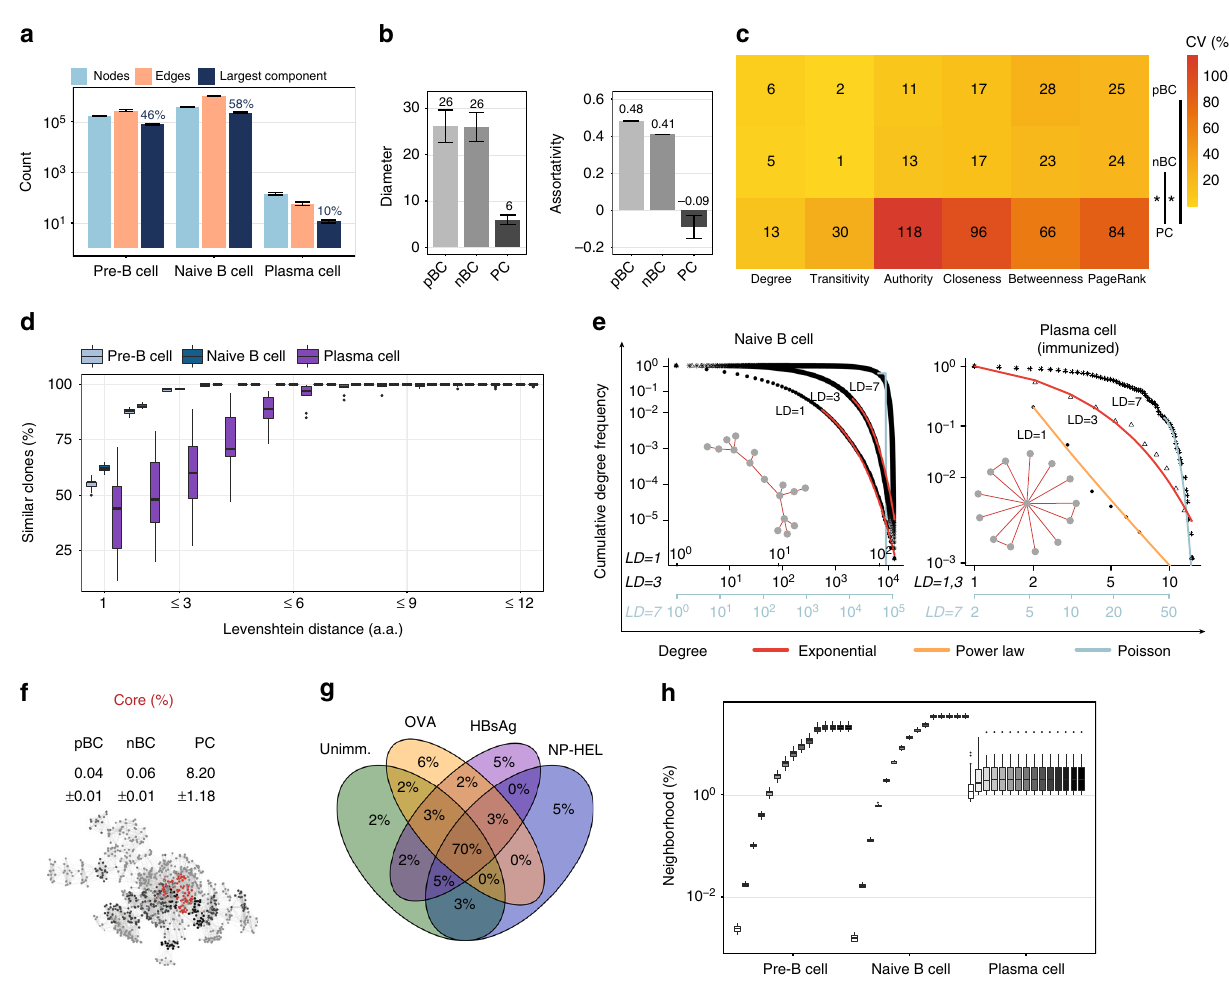
Fig. 2 Global and clonal properties of antibody repertoire networks are reproducible. a Network size of antibody repertoires. The y -axis indicates the absolute number count of CDR3 nodes, CDR3 edges (similarities) and CDR3 clones in the largest component. The mean percentage of the CDR3s belonging to the largest component by B-cell development stage is shown on top of the dark blue bar. b Global properties, diameter and assortativity coef fi cient are shown for pre-B cells (pBC), naïve B cells (nBC) and plasma cells (PC). c The mean value of the coef fi cient of variation for clonal properties in pBC, nBC and PC repertoires. Wilcoxon test, p pBC,nBC/PC < 0.05 (see Methods). d Percentage of clones connected to at least one other clone in the repertoire at LD 1 , LD ≤ 2 , … , LD ≤ 12 in pre-B cells, naïve B cells, plasma cells. e The power-law (orange), exponential (red) and Poisson (gray) distributions were fi t to the cumulative degree distributions of naïve B cell and plasma cell (unimmunized) repertoires of a representative sample for similarity layers LD 1,3,7 (log-log scale). Representative clusters are shown for LD 1 . f Percentage of CDR3 clones (mean ± s.e.m) that compose the maximal core. Subgraph of the maximal k-core (red), and k-1 (black), k-2 (dark gray) and k-3 (light gray) cores in a representative mouse pBC sample. g Percentage overlap of CDR3 germline V-genes in the maximal core of nBC repertoires ( n = 5 mice and data sets for Unimm (unimmunized), OVA, NP-HEL, n = 4 mice sets for HBsAg, mean ± s.e.m). h Normalized neighborhood size for orders n = {1 – 10, 15, 20, 30, 40, 50} across CDR3 clones (similarity layer LD 1 ). For a, b, d, barplots show mean ± s.e.m; for a – e, each B-cell stage n = 19 mice. Source data are provided as a Source Data fi